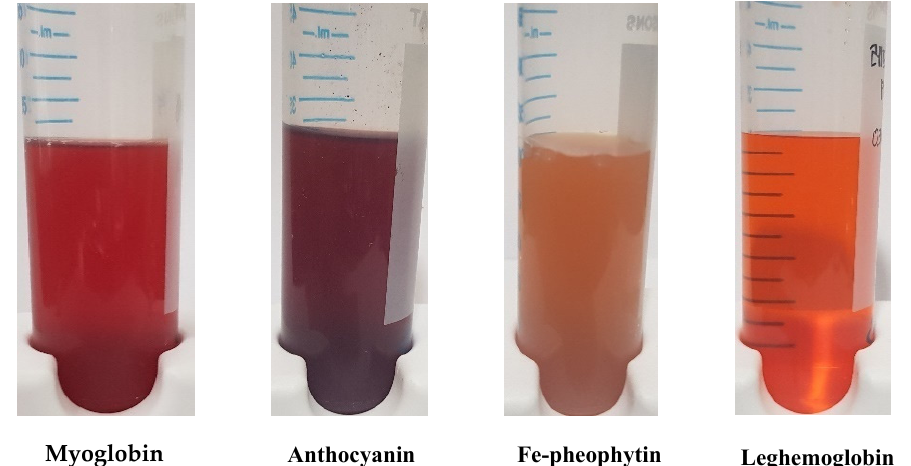
Figure 7. Pigment samples 30 mL in a 50 mL conical tube ( Φ 3 cm) each.